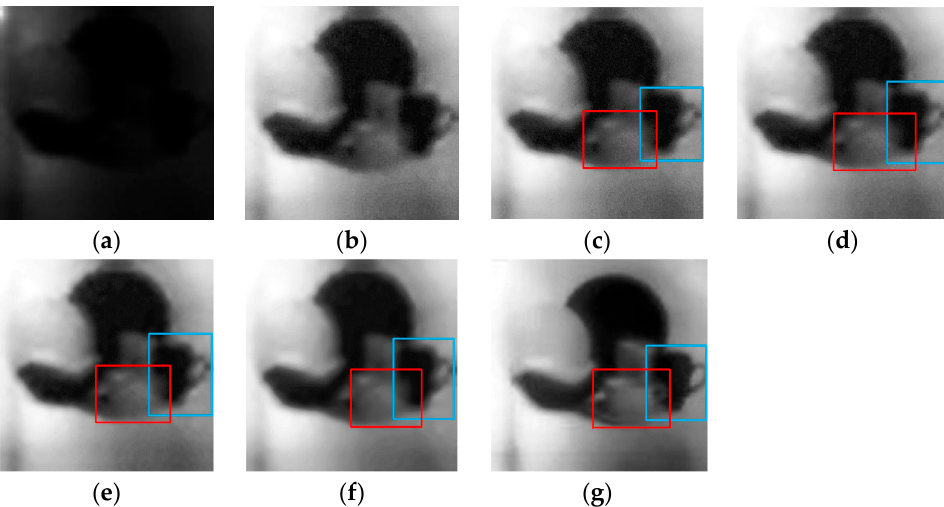
Figure 7. Comparison of different algorithms’ denoising effects on a photon counting image of a combination of balls and cups (detected under 2.19 × 10 − 3 lux environment with scanning resolution of 100 × 100). ( a ) Photon counting image; ( b ) reconstruction by HE; ( c ) reconstruction by WA-based HE; ( d ) reconstruction by WA-FICA-based HE; ( e ) reconstruction by NSCT-based HE; ( f ) reconstruction by BM3D -based HE; ( g ) reconstruction by proposed algorithm. The decomposition layer was three, direction number was 4, 8, and 16 in NSCT, the block size was 8, the sliding step to process every next reference block was 3, and the maximum number of similar blocks was 16. The threshold for the block distance was 3000 and the filtering parameters are referred to in the literature [39].